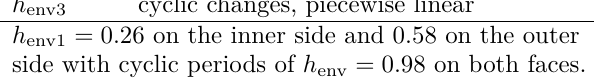
Table 4. Definition of ambient relative humidity.